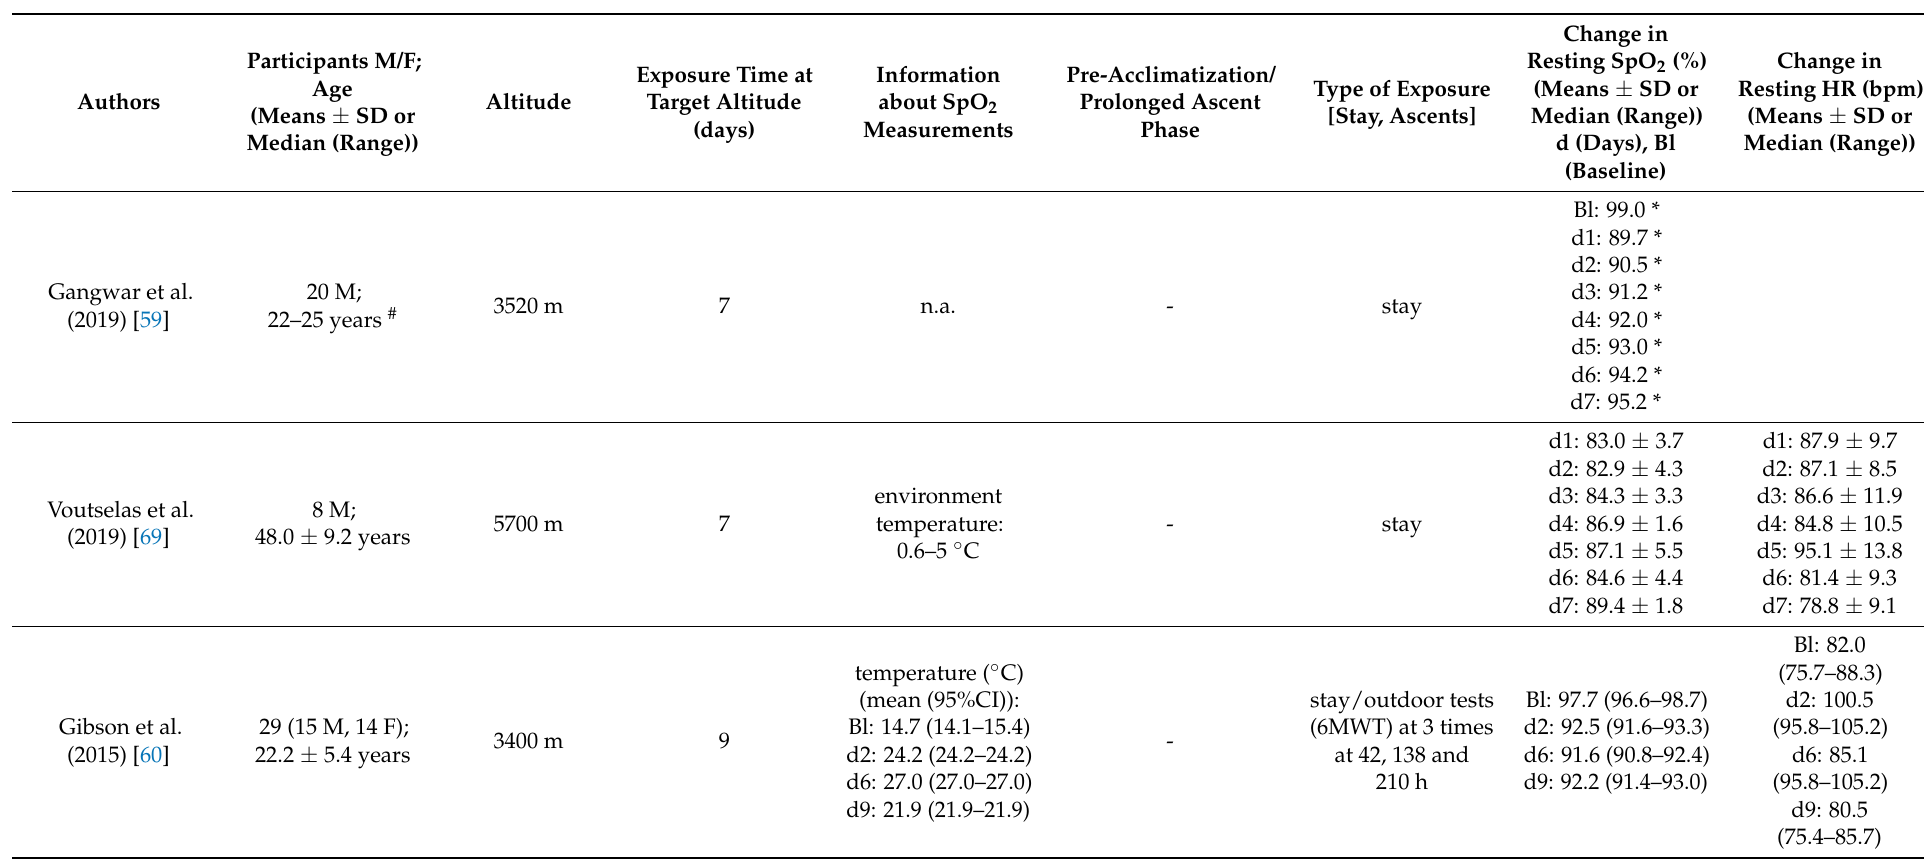
Table 2. Changes in resting SpO 2 and HR during acclimatization to high